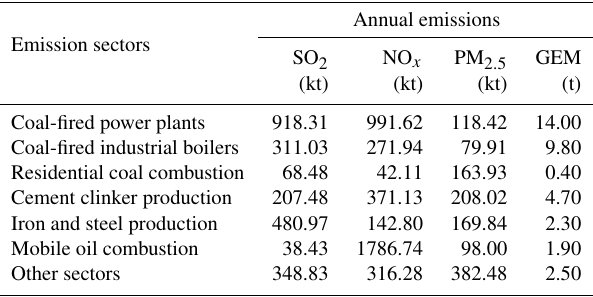
Table 2. Emissions of the main air pollutants in the YRD region in 2014.